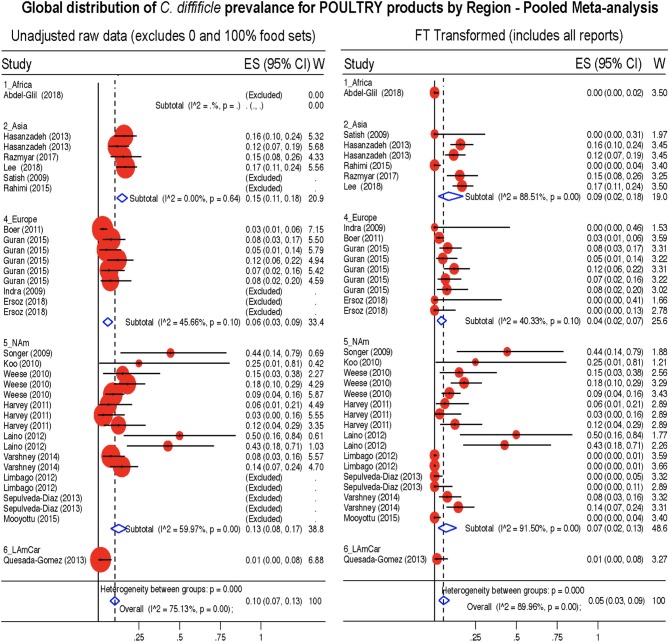
Global Prevalence of C. difficile in Poultry. Untransformed data (left) and Freeman-Tukey Double Arcsine Transformation (right).